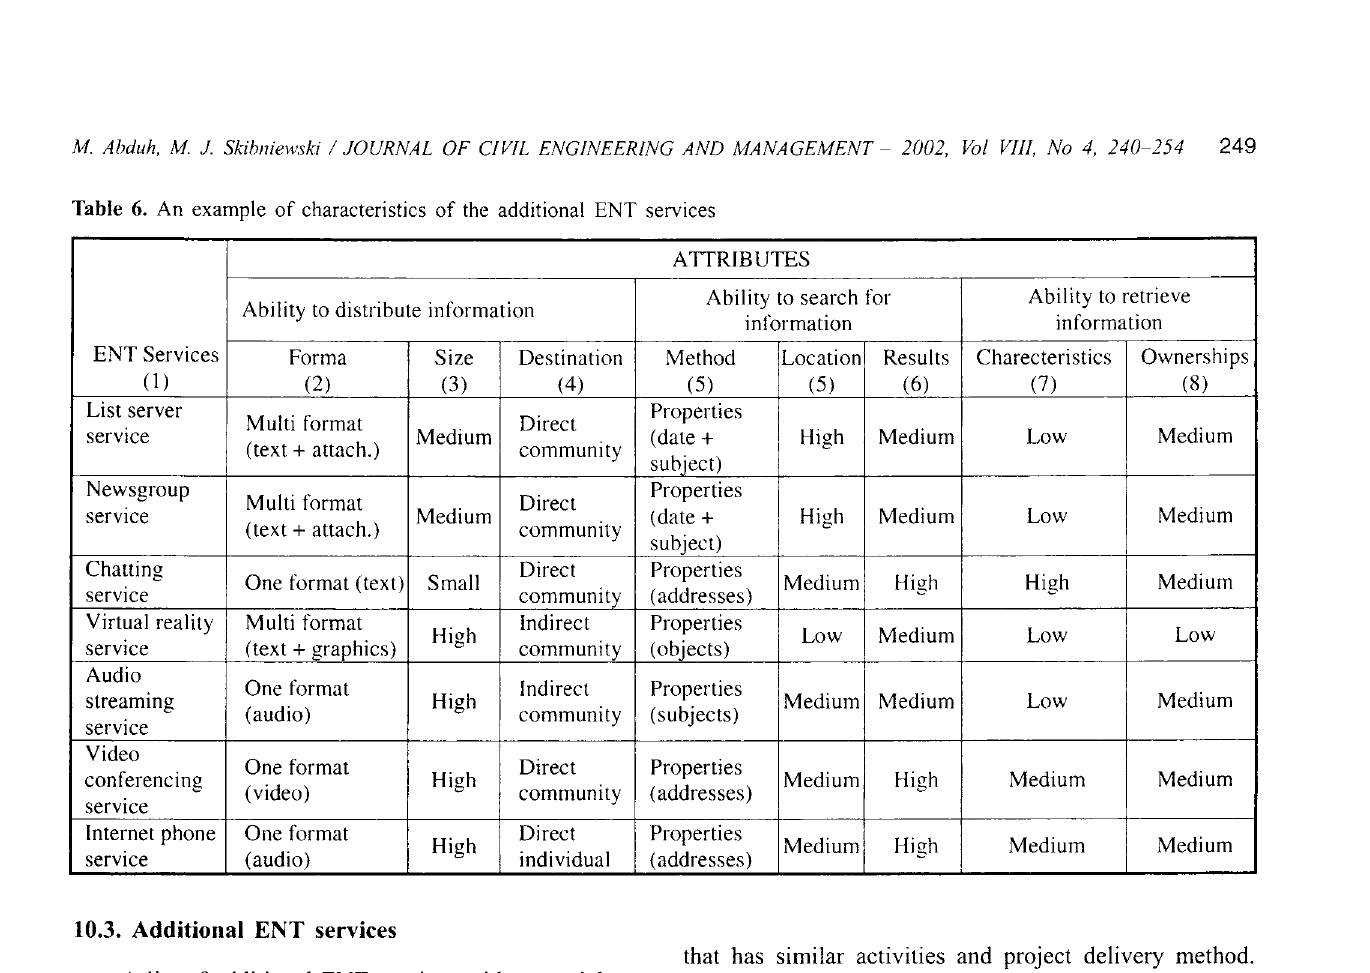
Table 6. An example of characteristics of the additional ENT services